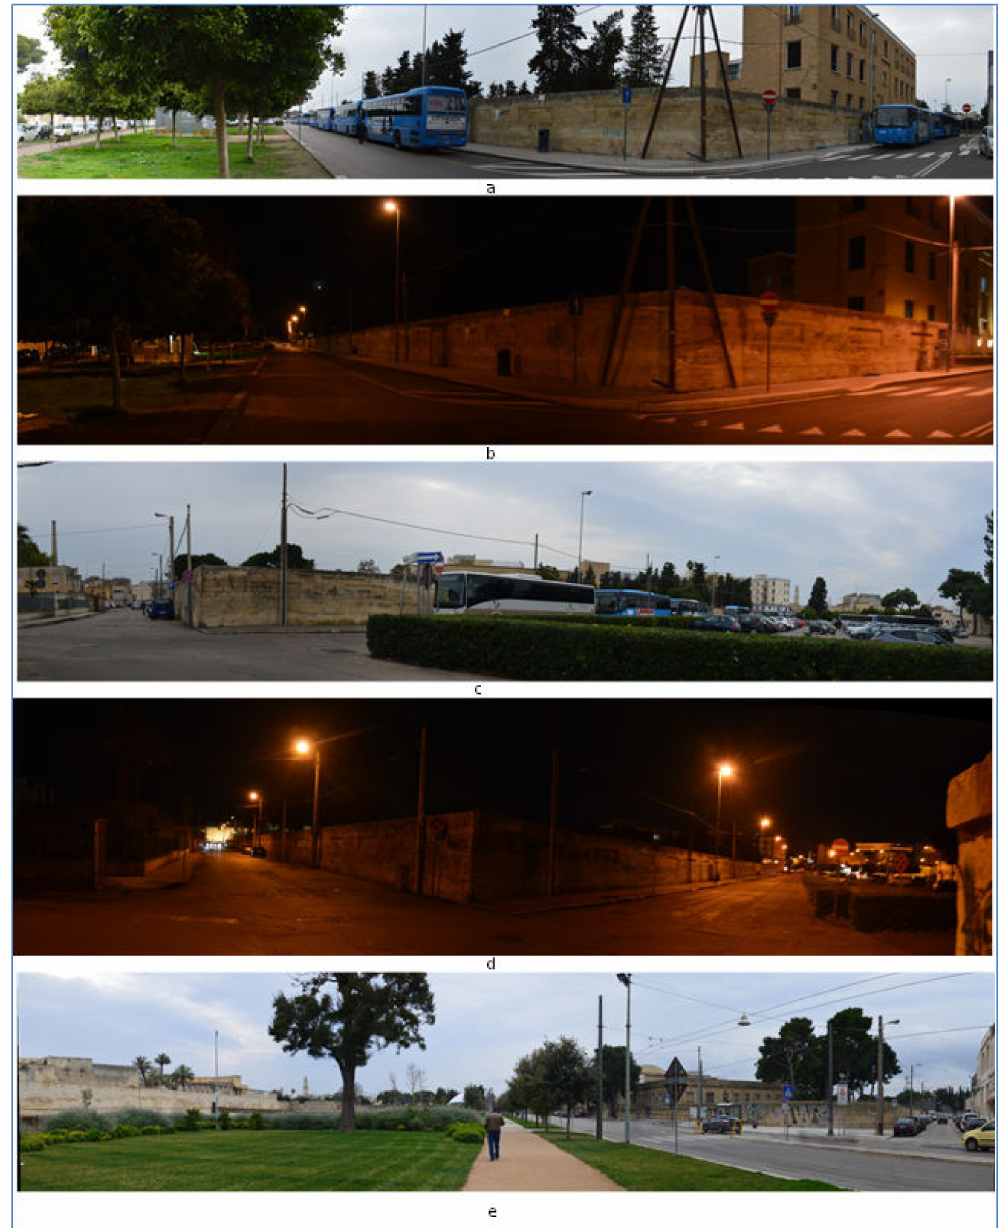
Figure 12. Photos of the enclosure wall. ( a , b ) are to the south–west side; ( c , d ) are to the north–west side; ( e ) is to the east